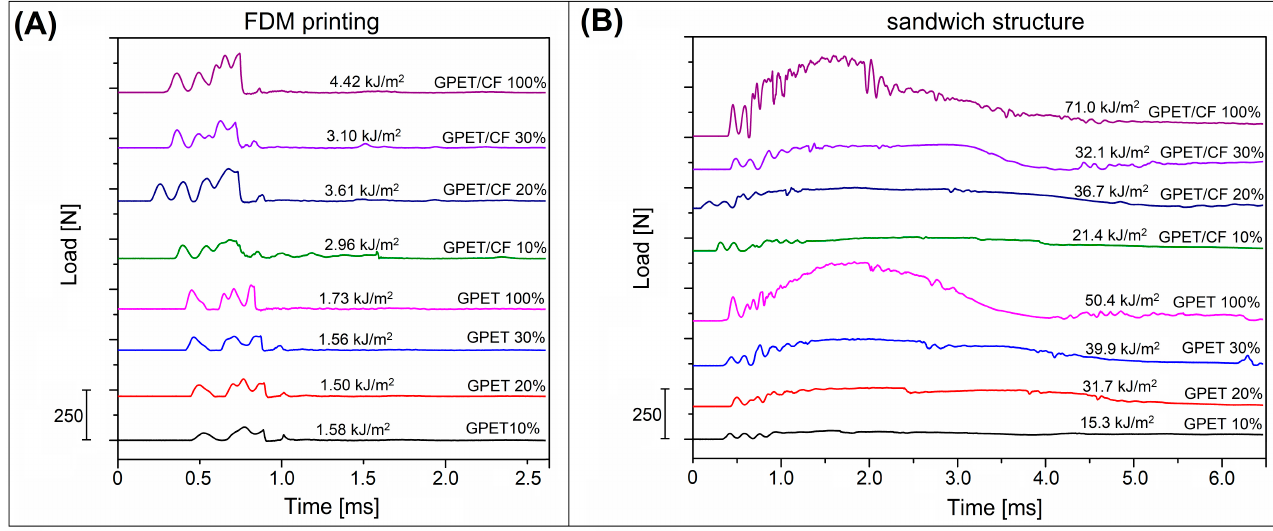
Figure 6. The load versus time plots recorded during the Charpy impact test: ( A ) for FDM-printed samples ( B ) and compression molded sandwich